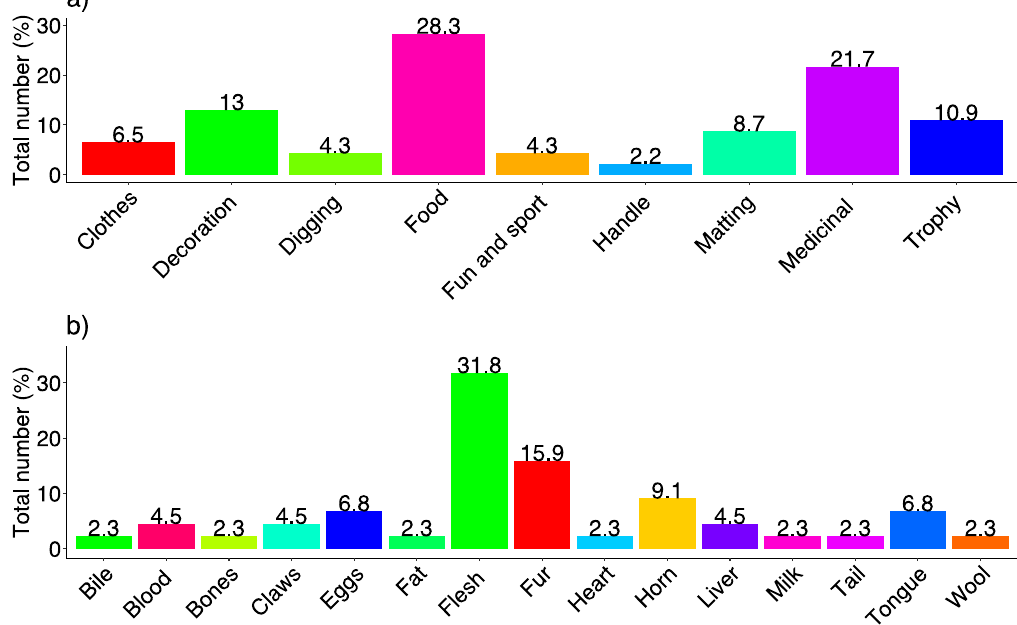
Figure 8. ( a ) Percentage of different ethnozoological usage; ( b ). Percentage of different animal body parts used. The percentage is based on the number of species used divided by the total number of species multiplied by 100.